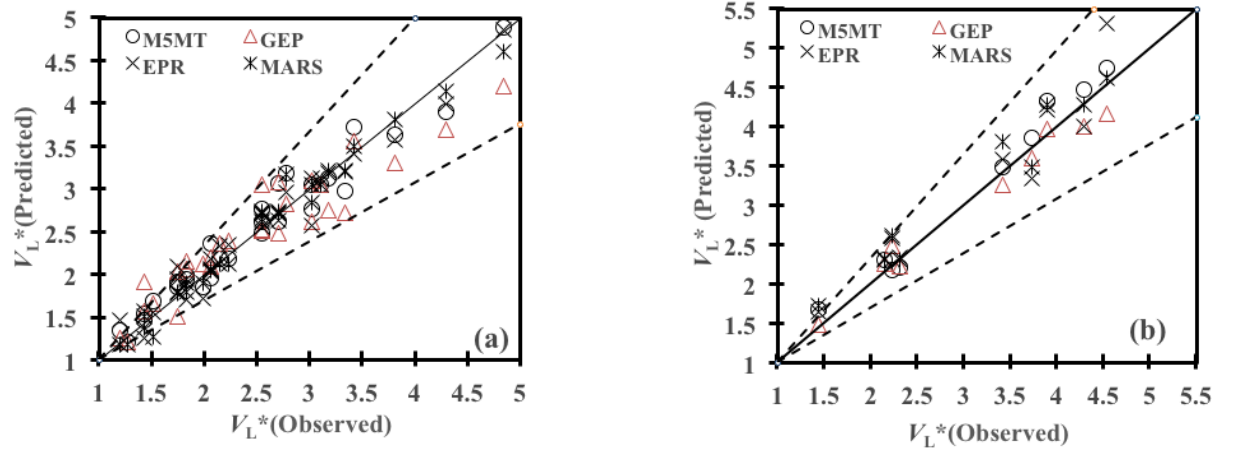
Figure 6. Performance of AI models in the prediction of 𝑉 𝐿∗ for: ( a ) training and ( b ) testing stage.